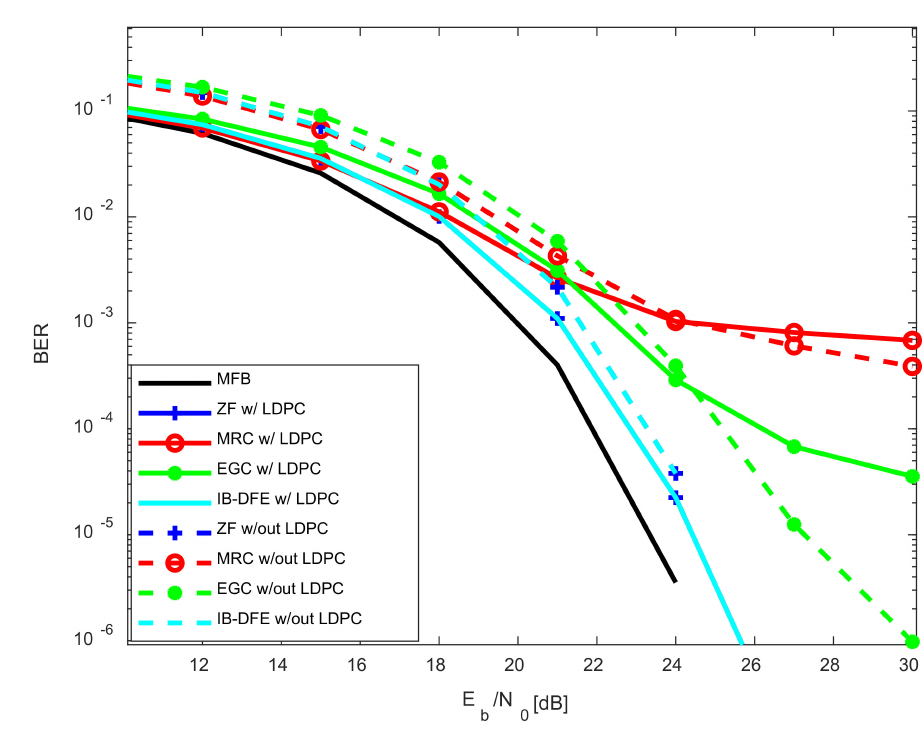
Figure 8. Results for 4 × 32 MIMO, with and without LDPC codes, impulsive noise, channel estimation, and channel correlation 0.5 between antenna elements.